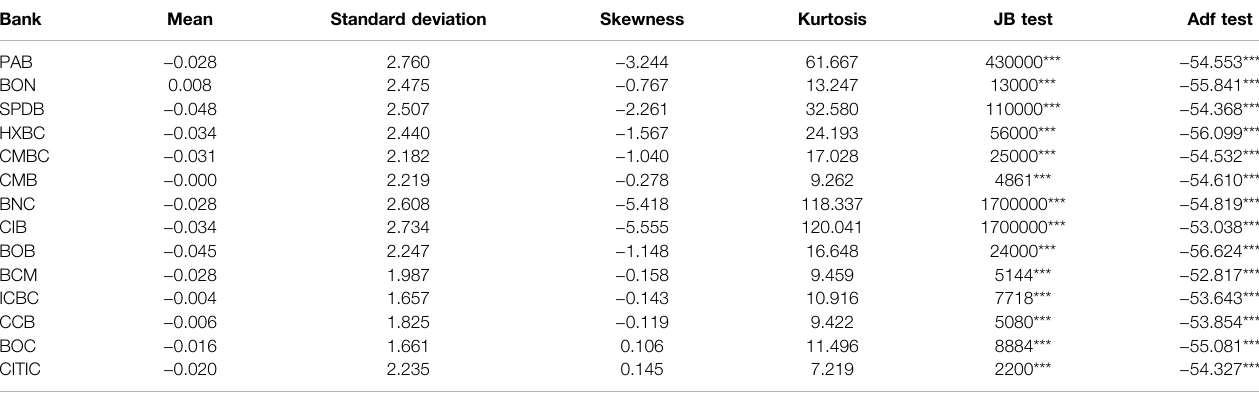
TABLE 2 | Descriptive statistics and characteristic test of the